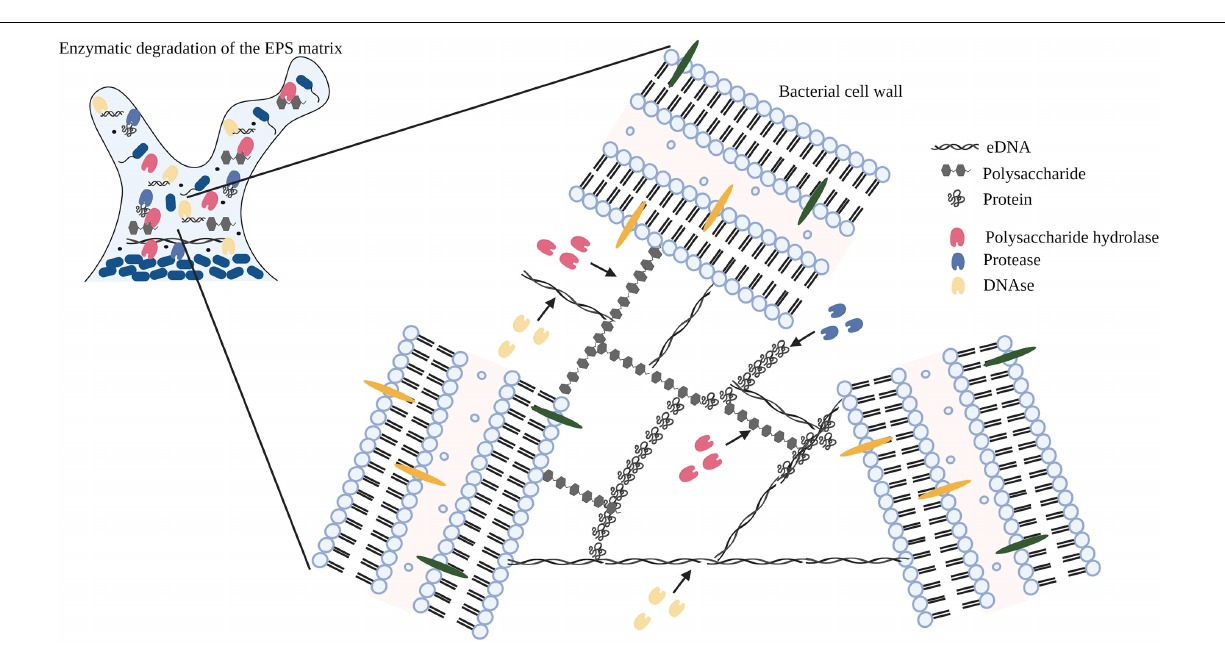
FIGURE 2 | Diagrammatic representation of the mechanism of action of enzymes (polysaccharide hydrolase, protease, and DNase) targeting exopolysaccharides, proteins, and eDNA within the EPS matrix. Image has been adopted from Nahar et al. (2018) with permission and was recreated with BioRender software. Black arrows indicate the binding of the enzyme to the